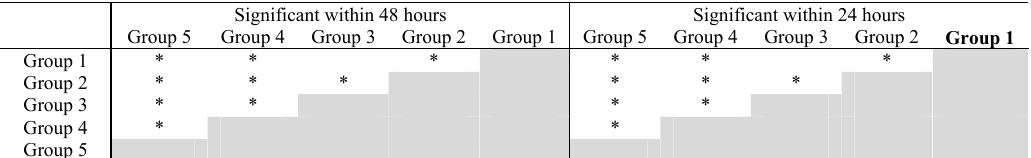
Table 9. Significance at concentration 2 at P<0.001 Table 9: Significance at concentration 2 at